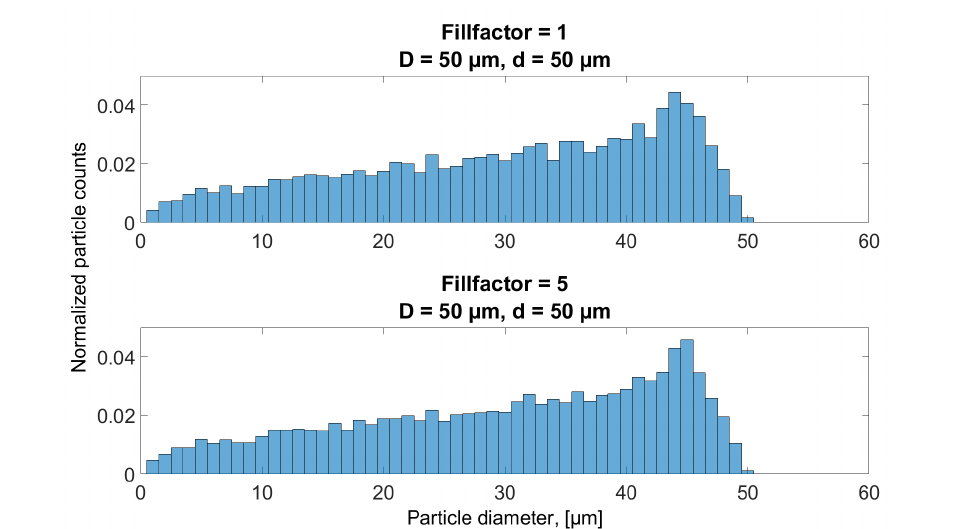
Figure 12. Evaluated particle counts when simulating two different concentrations of 50µm diameter particles, when using a 50µm diameter aperture. Histograms are normalized such that the sum of all bars equal